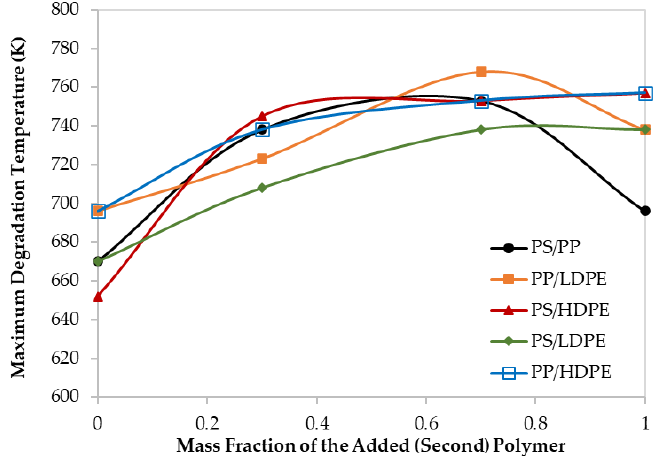
Figure 4. Maximum decomposition temperature for different polymer blends at 60 K/min. The thermograms maximum temperatures (T peak ), obtained from the derivative